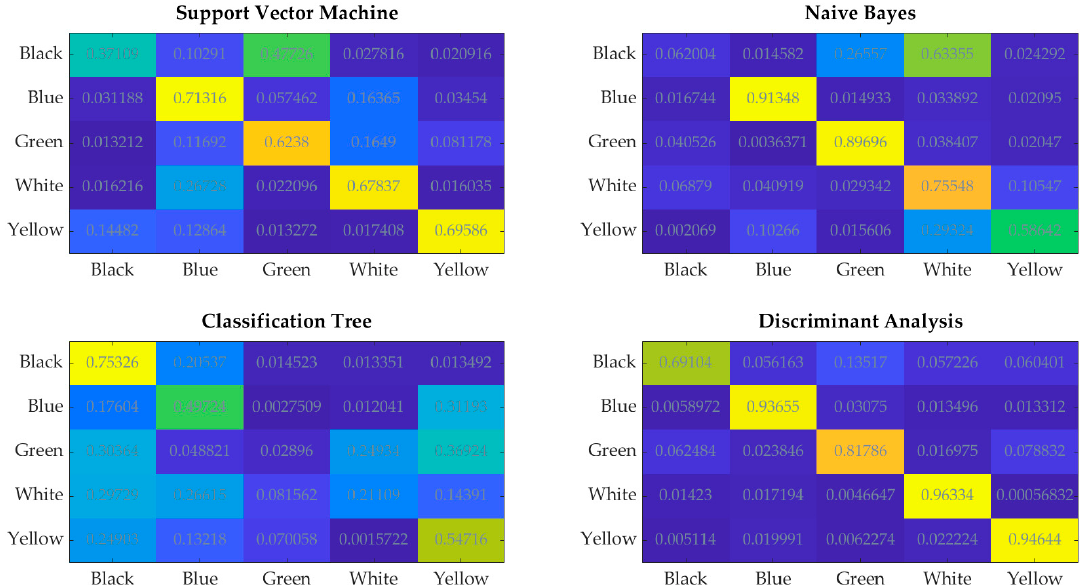
Figure 15. Confusion matrix of support vector machine (SVM), naive Bayes (NB), classification tree (CT), and discriminant analysis (DA) classification algorithms.